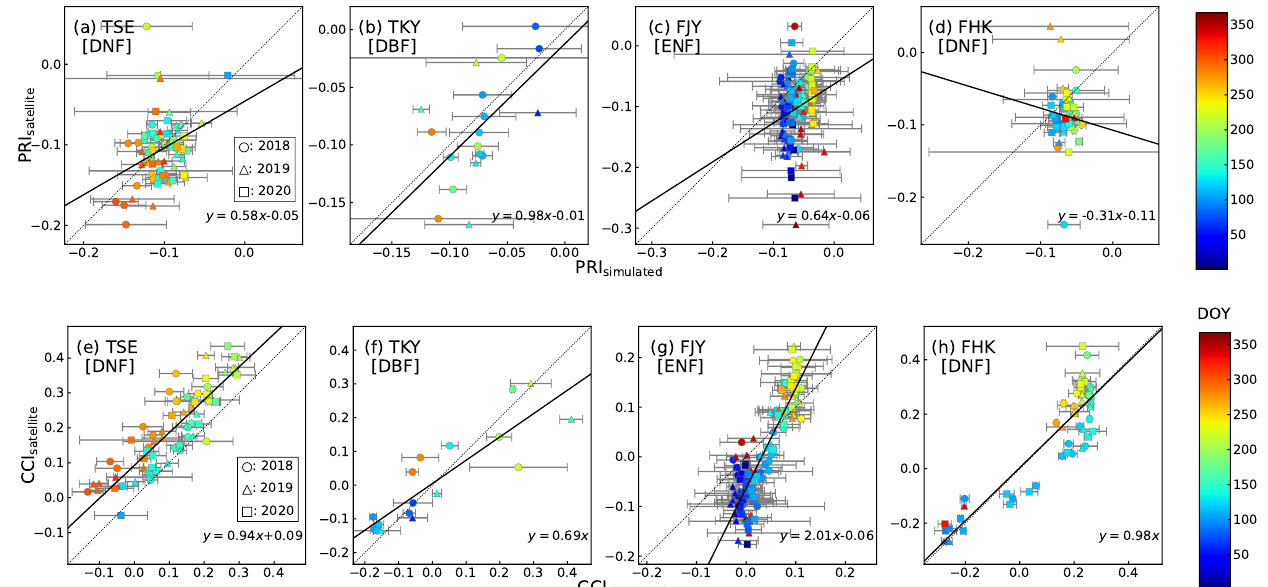
Figure 18. Scatter plots of spatial mean of PRI satellite ( a – d ) and CCI satellite ( e – h ) calculated from four neighbor pixels. Satellite data were screened with the QA flag (QA = 2). The error bar represents standard deviation for each point. The dotted line represents the 1 : 1 line. The black solid line is the linear regression line. The shape of each point represents the year. The color of each point corresponds to the DOY. Table 9. The statistics of the accuracy assessment of PRI satellite and CCI satellite with the mean value of four neighbor